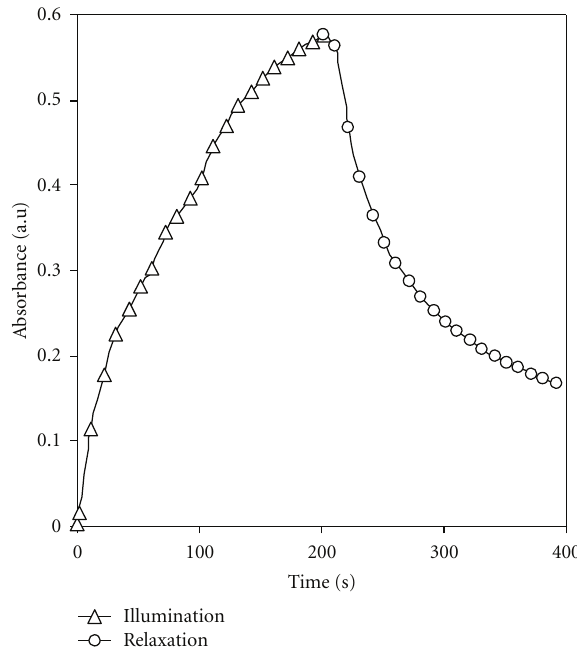
Figure 4: Typical growth and relaxation process of photoinduced absorbance modulation of SPO-7OH in P(MMA-BMA) at 303